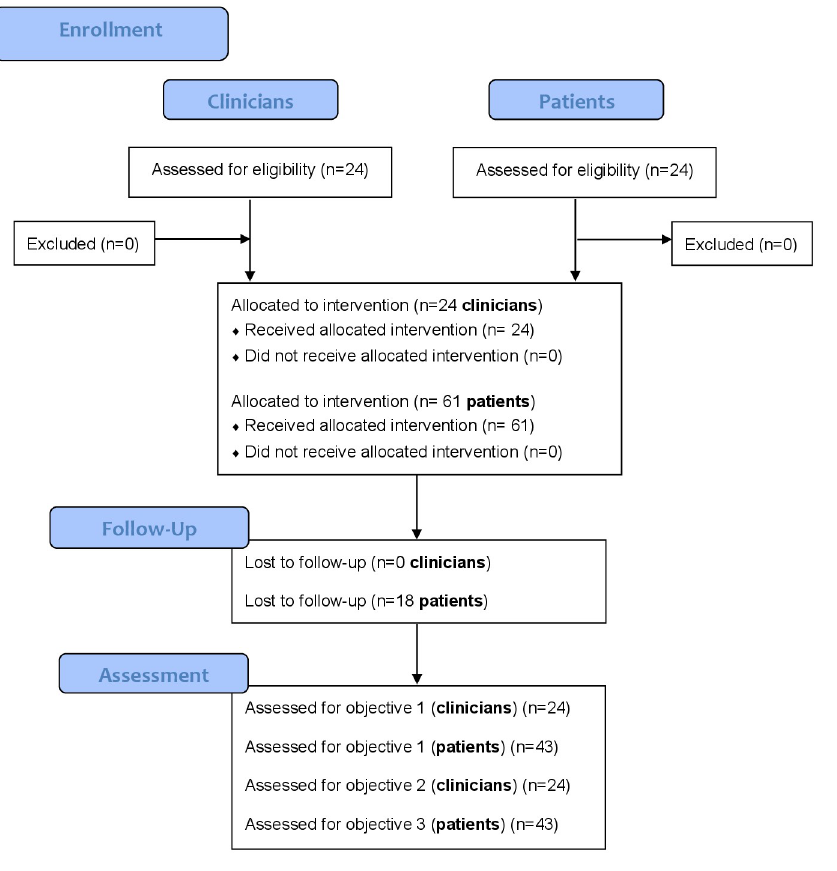
Fig 1. Study flowchart.